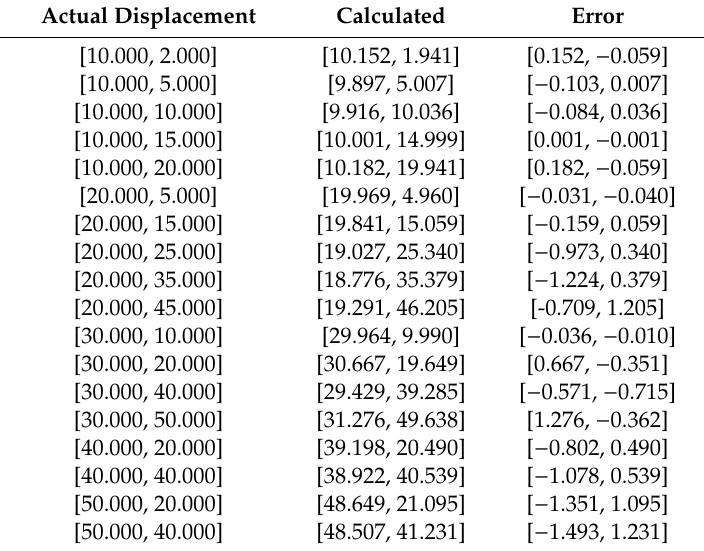
Table 2. Measuring result of [horizontal displacement, vertical displacement] of 0 ◦ tilt angle (unit: mm).